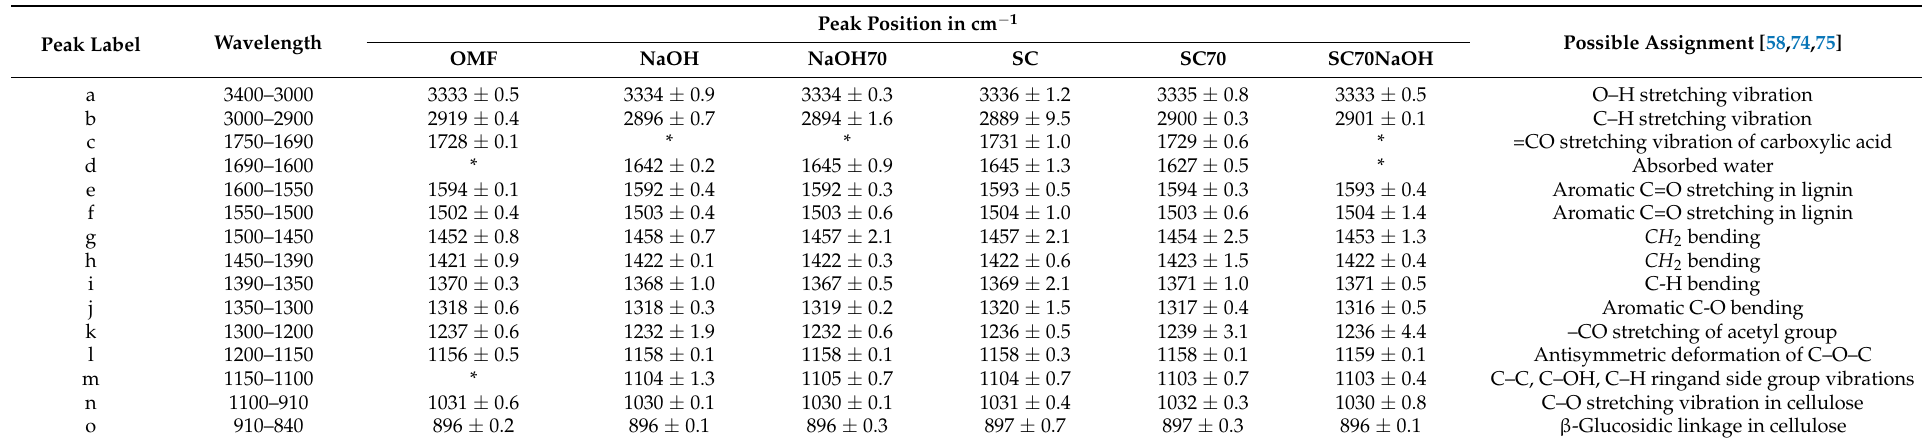
Table A2. FTIR spectral data for treated and untreated OM fibres.